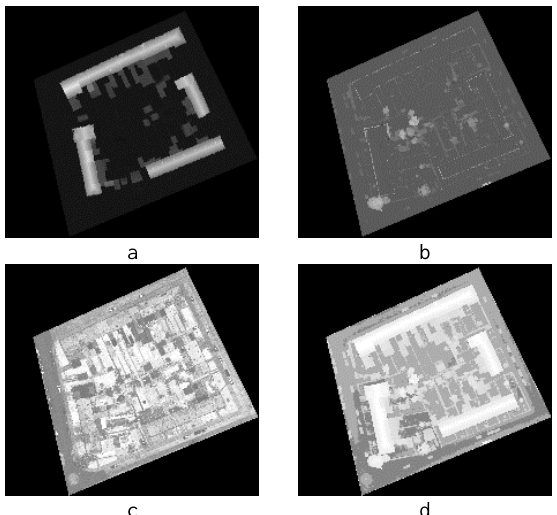
Figure 3. Extracted Features for LiDAR data. a. difference between last pulse and DTM. b. difference between first and last pulse range. c. First pulse intensity. d. First pulse